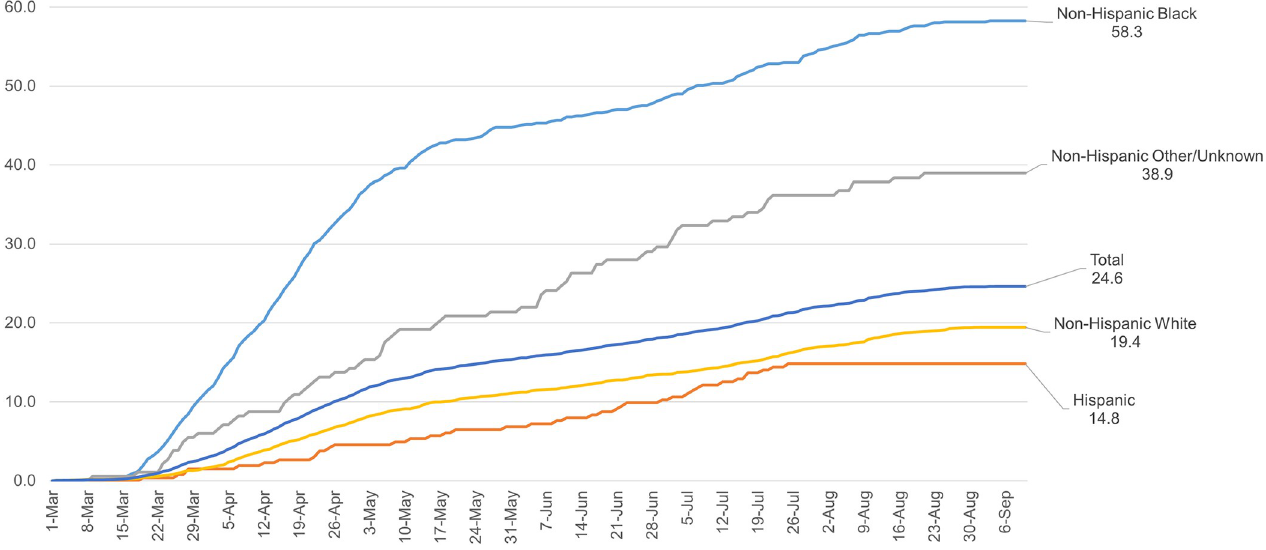
Fig 2. Cumulative COVID-19 related deaths per 100,000 by race and ethnicity, Missouri residents, Mar. 1, 2020 –Sep. 10, 2020. Source: Authors’ analysis of COVID-19 case data from the Missouri Department of Health and Senior Services and 2018 population estimates from the U.S. Census American Community